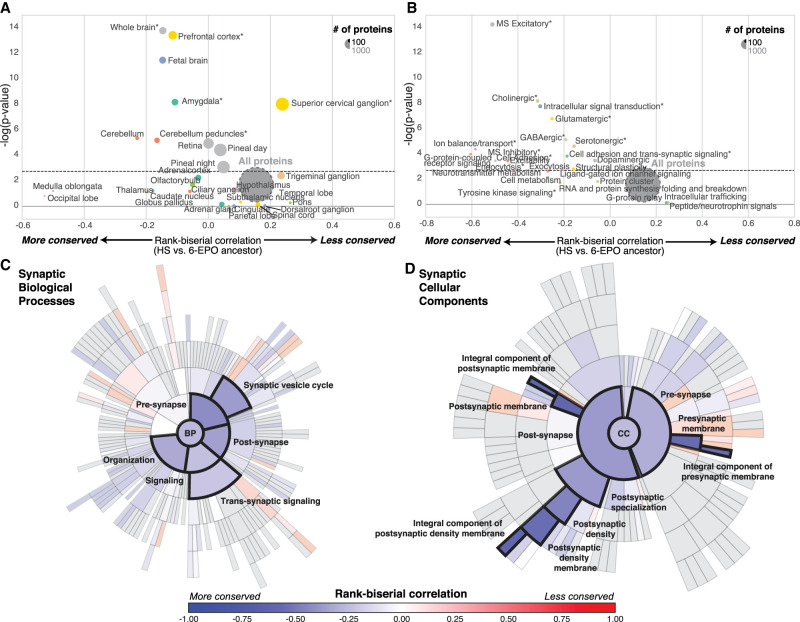
Evolution of brain-related protein-coding genes. (A,B) Funnel plots summarizing the evolution of protein-coding genes specifically expressed in brain substructures (A) and synaptic functions (B); the dashed horizontal line indicates the threshold for significance after Bonferroni correction. Stars indicate sets of genes for which statistical significance was achieved for multiple comparisons with bootstrap correction. (C,D) SynGO sunburst plots showing nested statistically conserved (blue) biological processes (C) and cellular components (D) of the synapse. The circle in the center represents the root node, with the hierarchy moving outward from the center. A segment of the inner circle bears a hierarchical relationship to those segments of the outer circle which lie within the angular sweep of the parent segment.